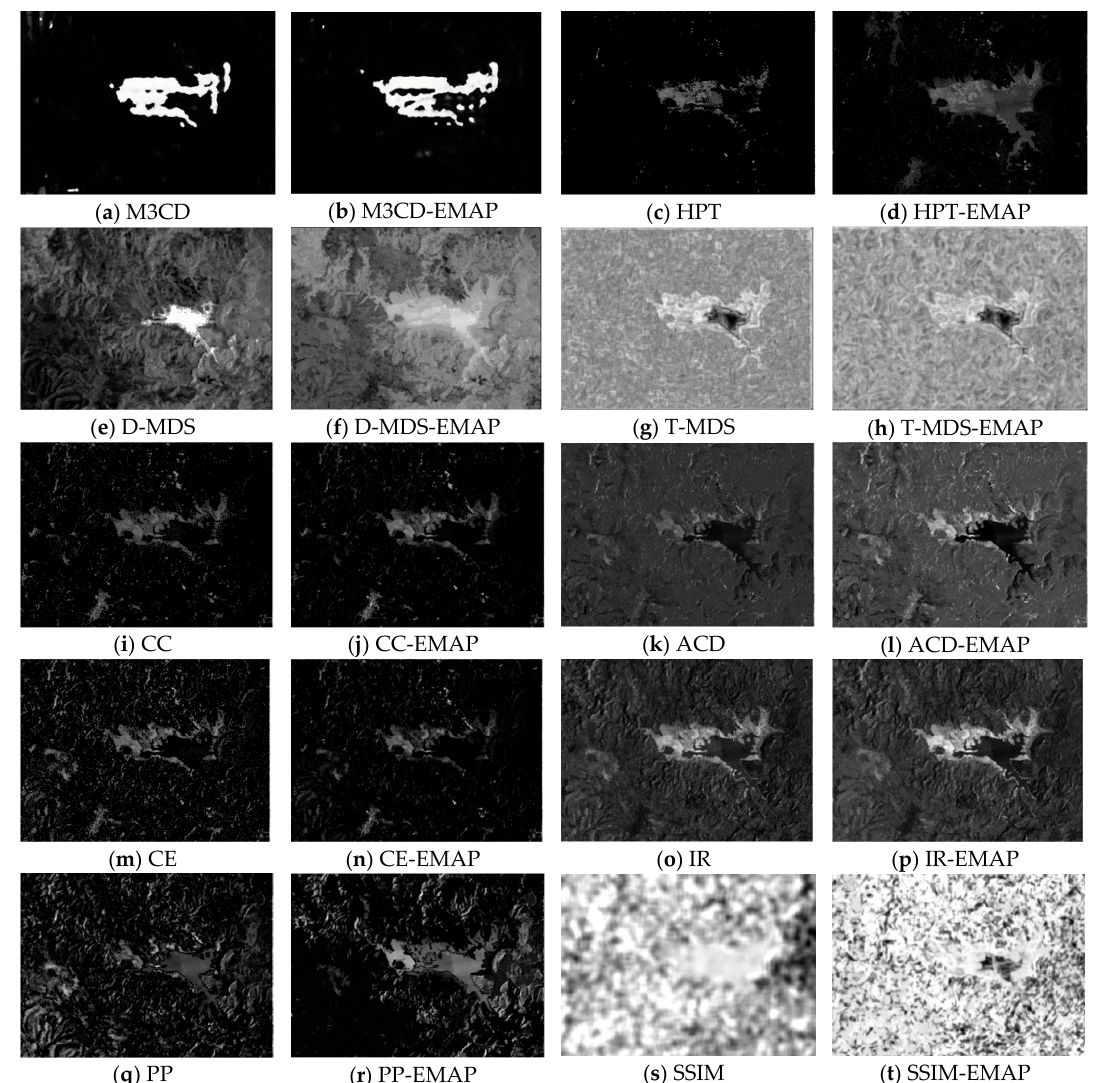
Figure 9. Change detection images using different methods with and without EMAP (Image Pair-2).